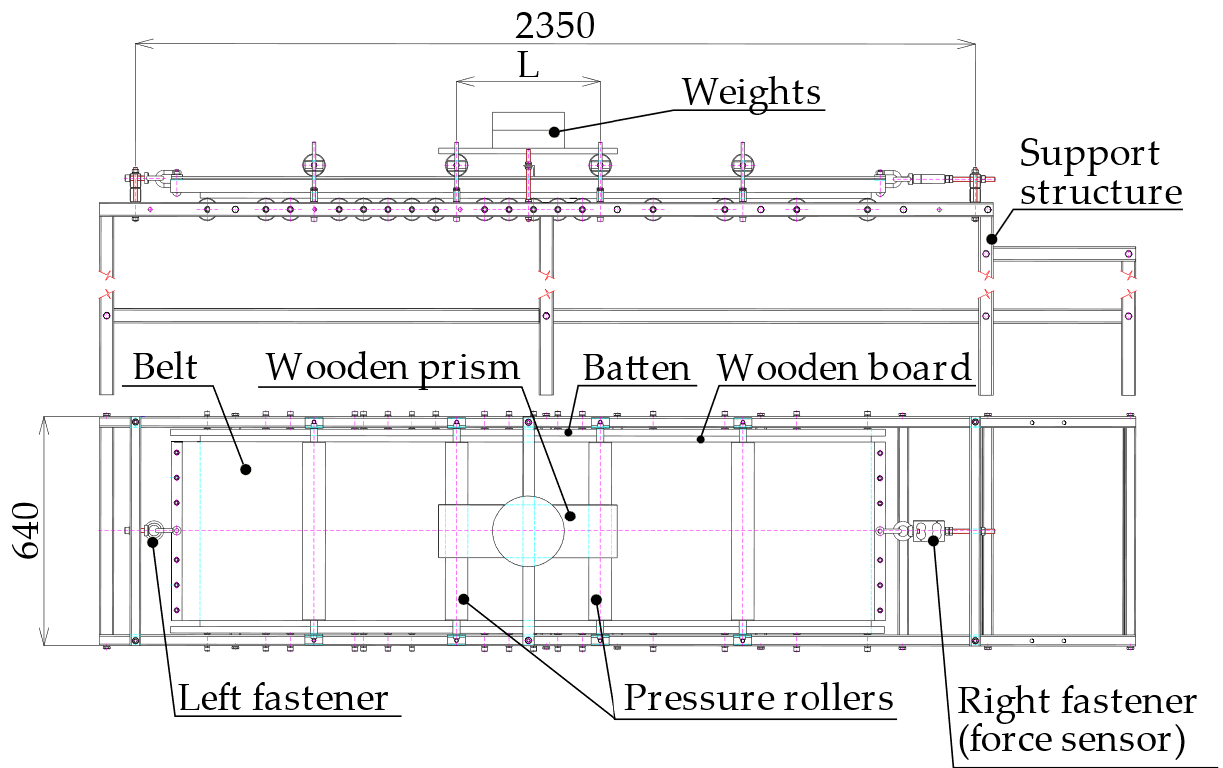
Figure 2. Device for measuring the deflection of a layer of loose material from the applied pressure force of a conveyor roller on a pressure belt, dimensions are in mm.